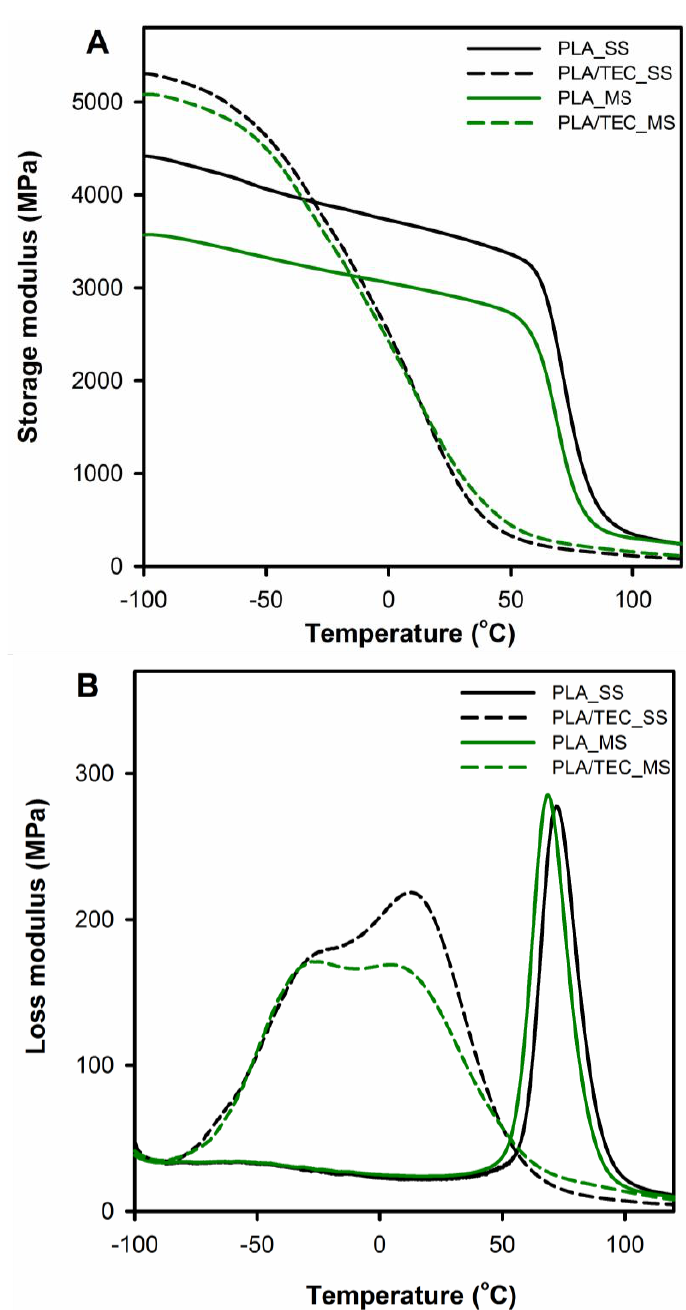
Figure 4. Temperature dependencies of storage modulus ( A ) and loss modulus ( B ) of PLA and PLA / TEC PLA/TEC systems.